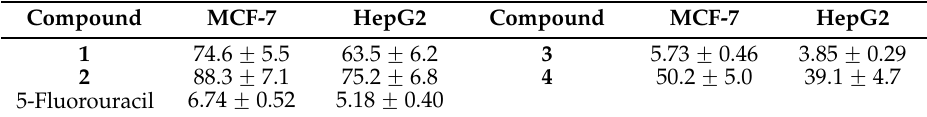
Table 3. Cytotoxicities of compounds 1 – 4 against MCF-7 and HepG2 cell lines (IC 50 , µ